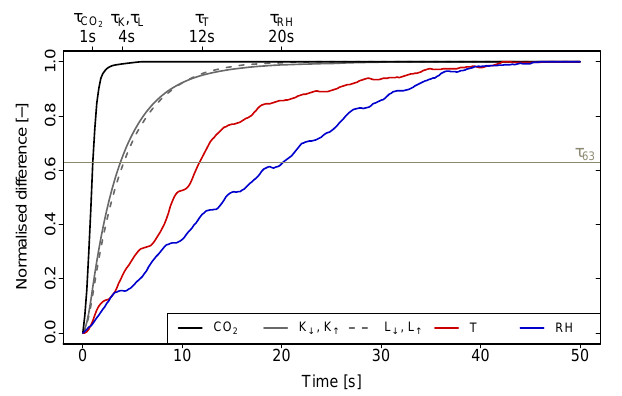
Figure 4. Example time series of temperature (top) and relative hu- midity (bottom) for one complete run of the HMMS during night- time of 28 June 2011. The runtime was 02:53–02:58CET in the forward direction and 02:58–03:03CET in the backward direction. The forest edge is indicated by the vertical green dotted line. The time series shows the uncorrected measured values (black solid line) and, at the forest edge, the corrected gradient (grey solid